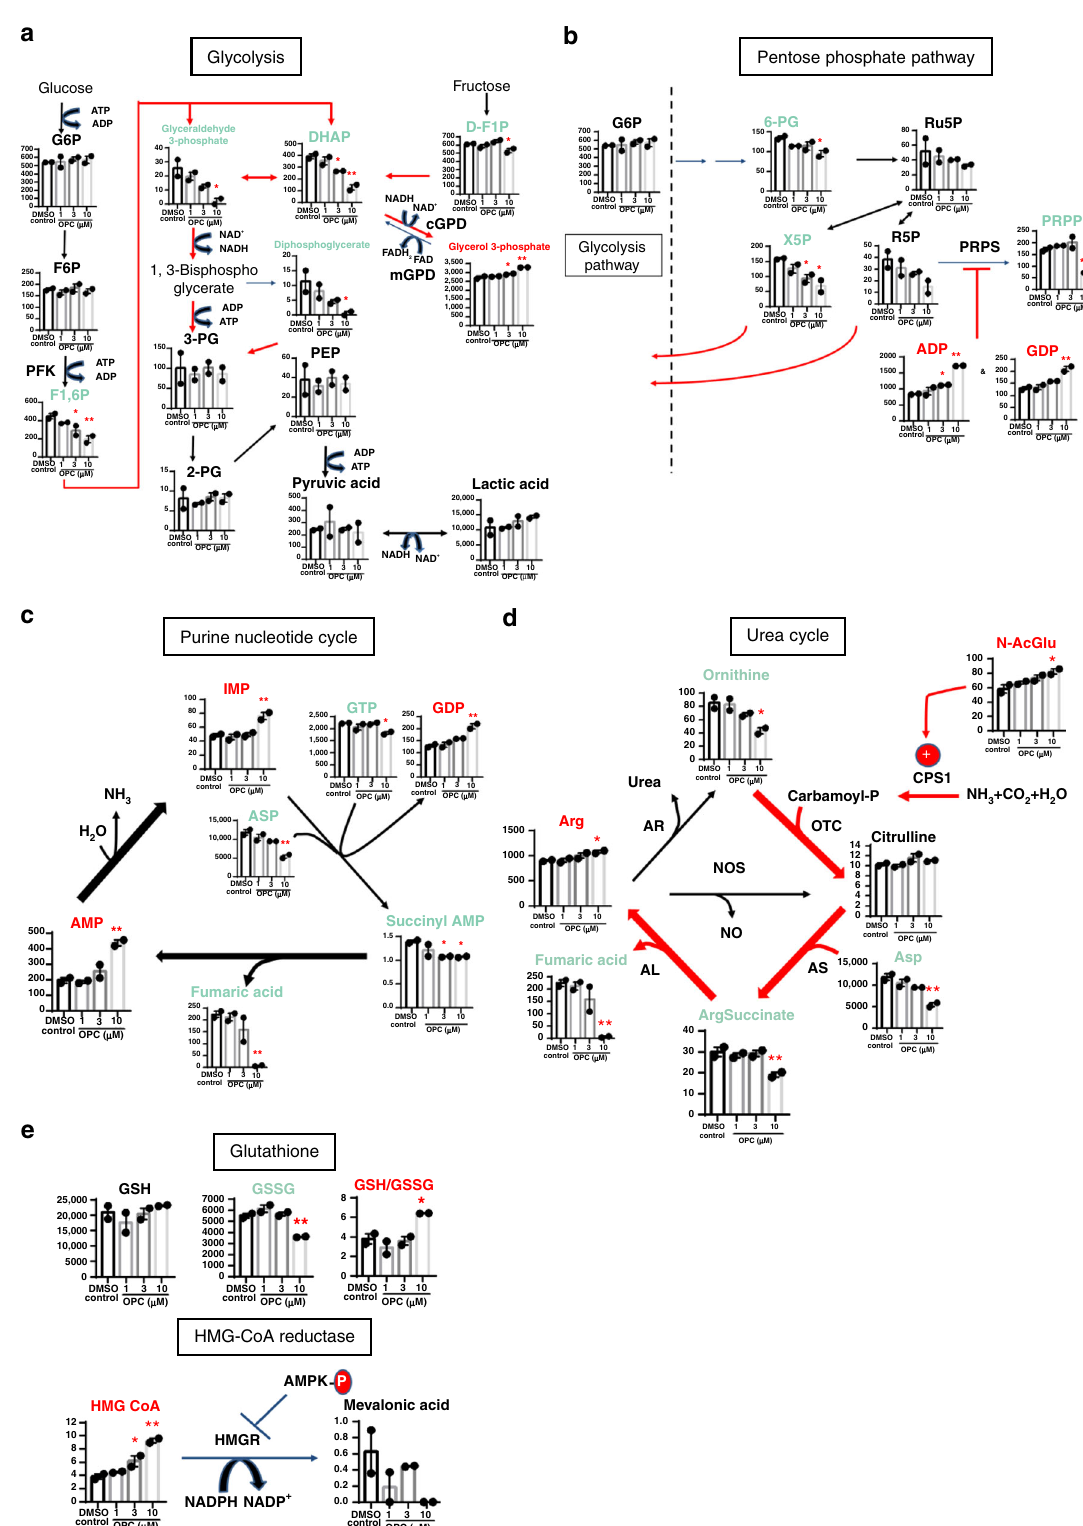
Fig. 6 Metabolomic analysis of in vitro effects of OPC-163493 in HepG2 cells. Data represent mean ± SE ( n = 2, ∗ P < 0.05, ∗∗ P < 0.01, OPC vs. DMSO control using a two-tailed Williams ’ test). a Effects on glycolysis. G6P glucose 6-phosphate, F6P fructose 6-phosphate, 3-PG 3-phosphoglyceric acid, 2-PG 2-phosphoglyceric acid, PEP phosphoenolpyruvic acid. b Effects on pentose phosphate pathway. 6-PG 6-phosphogluconic acid, Ru5P ribulose 5-phosphate, X5P xylulose 5-phosphate. c Effects on purine nucleotide cycle. d Effects on urea cycle. OTC mitochondria ornithine transcarbamoylase, AR arginase, NOS nitric oxide synthases. e Effects on glutathione redox and HMG-CoA